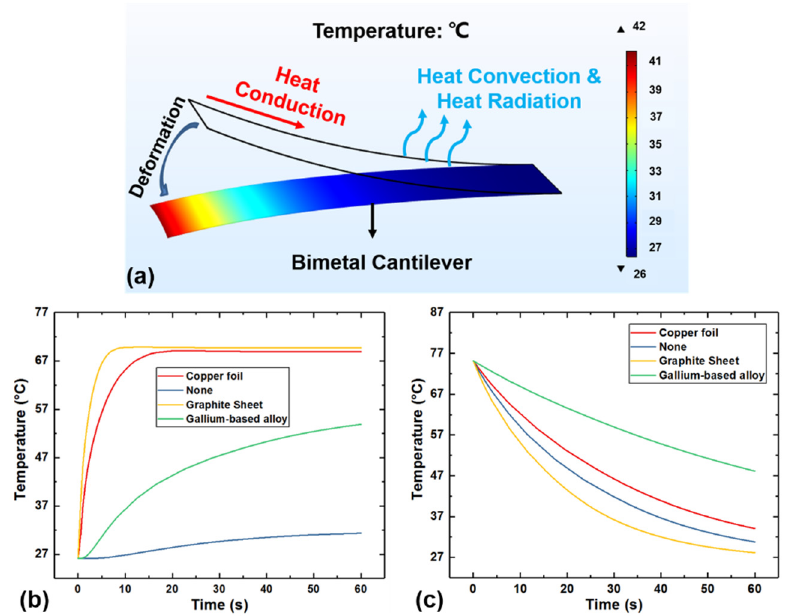
Figure 2. Heat conduction/dissipation simulation of the bimetallic cantilever. ( a ) Schematic diagram of the thermal deformation of the bimetallic cantilever; ( b ) the temperature curves when attaching different thermal conductive materials; and ( c ) the heat dissipation curves when attaching different thermal conductive materials.